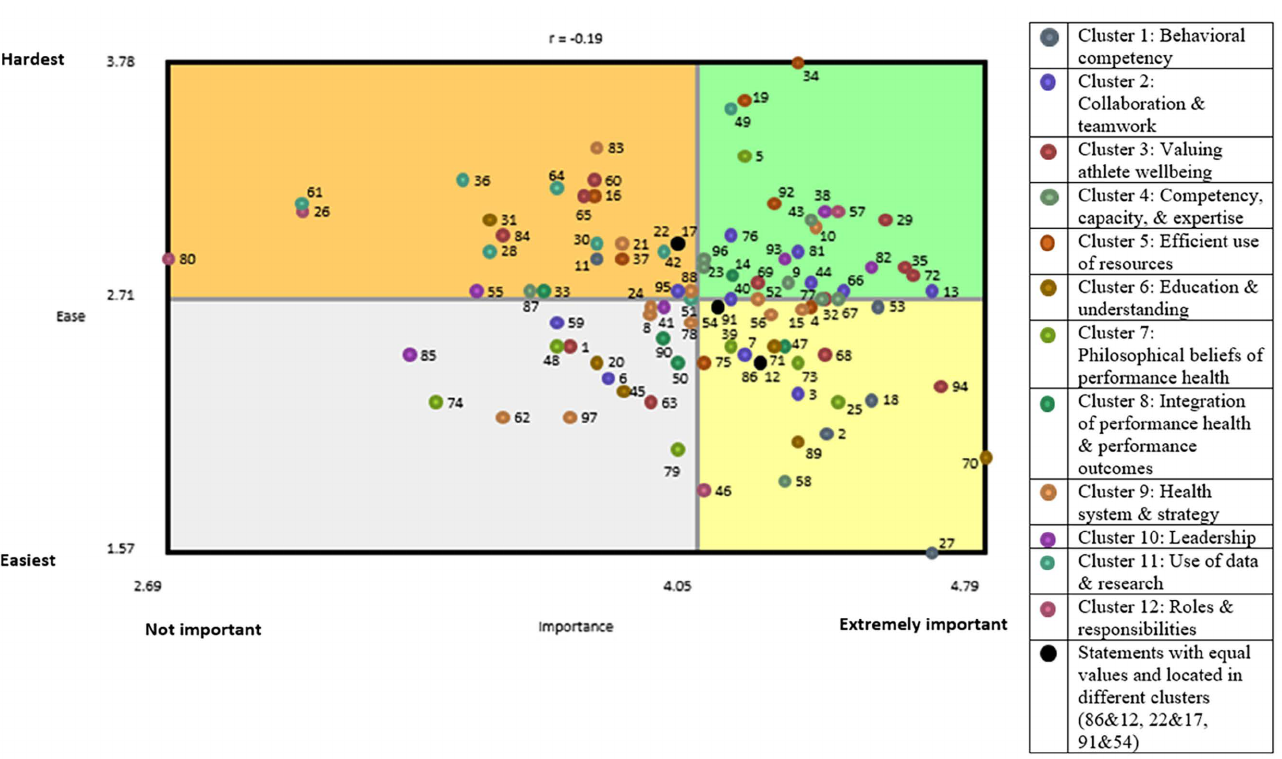
Figure 2. Go-zone graph of ideas from members of Australia’s high-performance sport system for achieving athlete performance